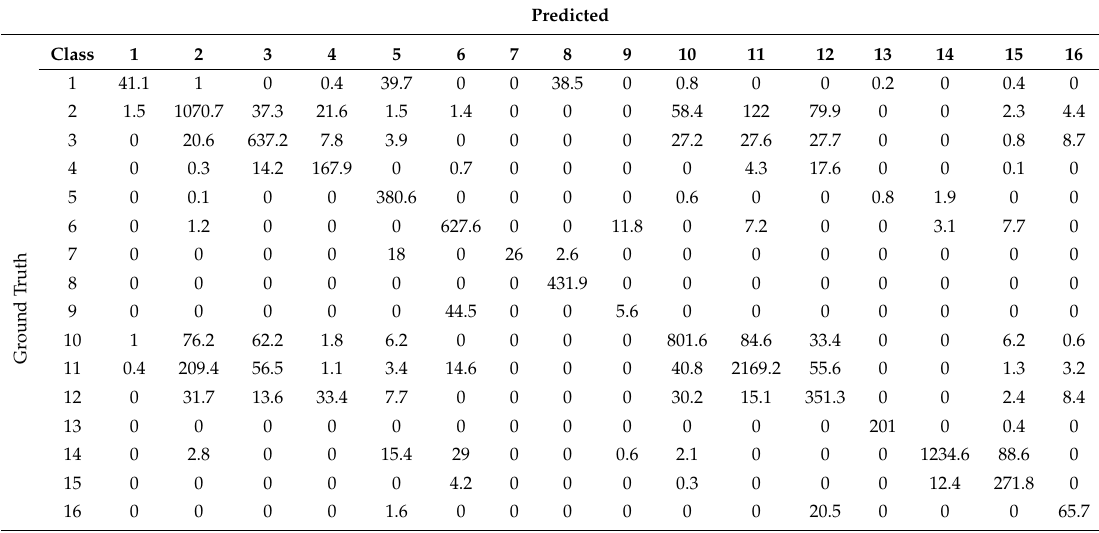
Table 6. The confusion matrix of the proposed SPFS-SRC from the Indian Pine dataset corresponding to Table